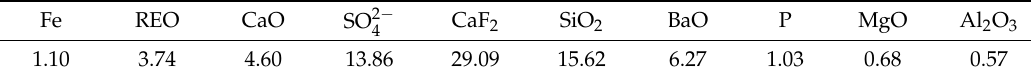
Figure 19. XRD patterns of the leaching residues.